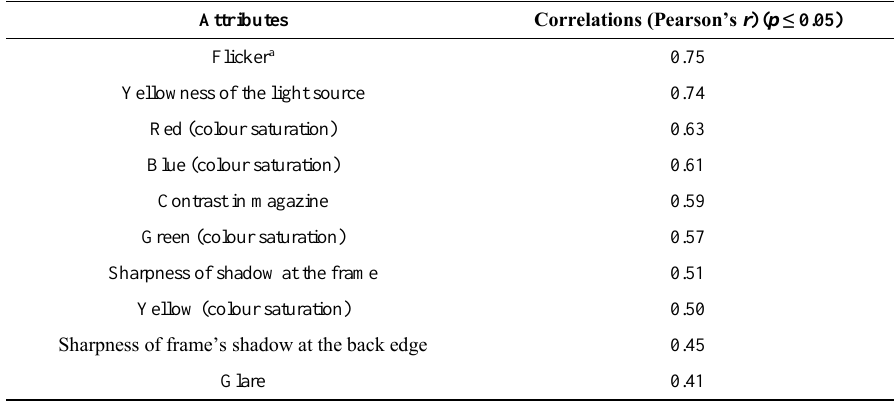
Table 7. Correlations for assessments in the laboratory compared to real context for attributes with a significance